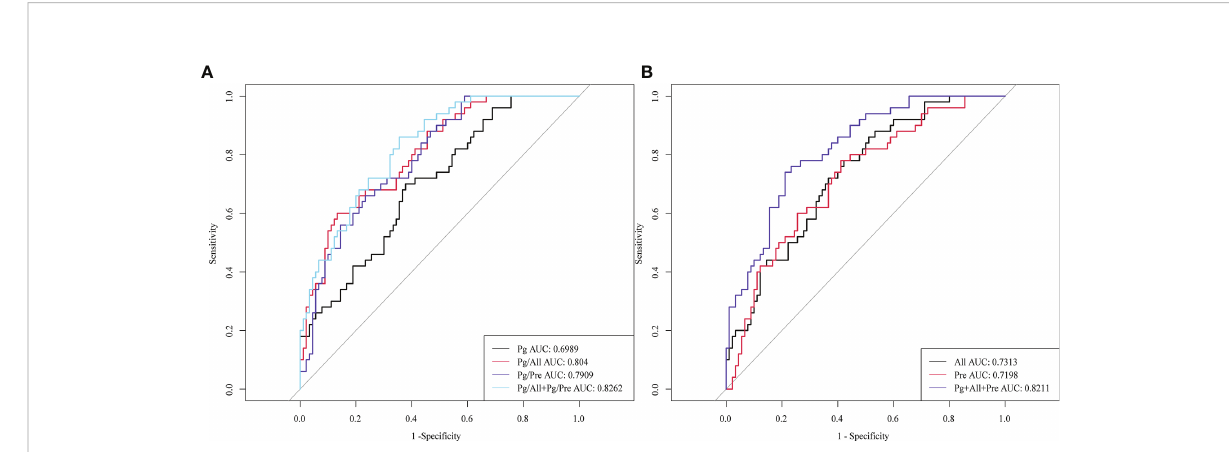
FIGURE 5 Diagnostic performance of salivary microbial ratios Pg/All and Pg/Pre compared with Pg , All , and Pre individually or in combination. ROC curves for the ability to distinguish ESCC patients from HCs for (A) Pg , the ratio of Pg/All , the ratio of Pg/Pre , and the combinations of Pg + All and Pg + Pre ; and for (B) All , Pre , and the combination of Pg + Pre + All